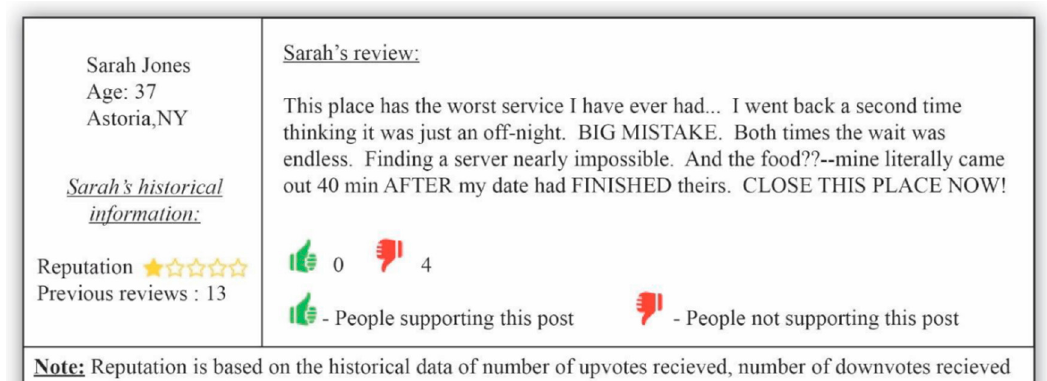
Figure 4. Non-anonymous and non-supporting user review of a restaurant with thumbs down, low reputation and small number of previous reviews.